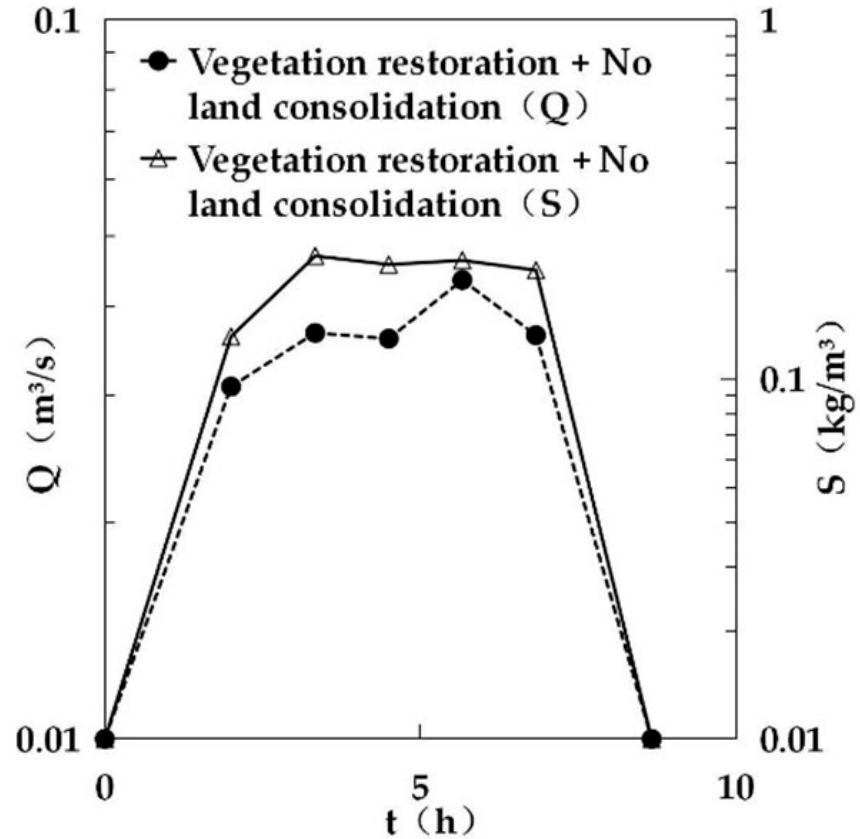
Figure 18. Changes in flow and sediment content before watershed control.